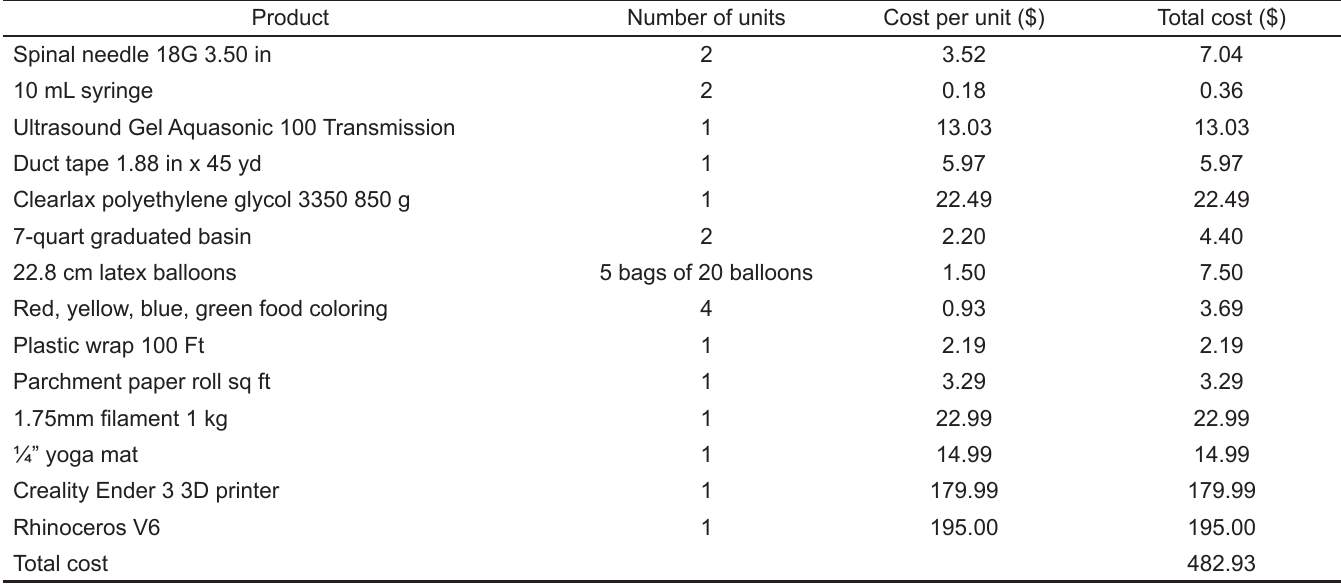
Table 1. Products used for the models including itemized costs.